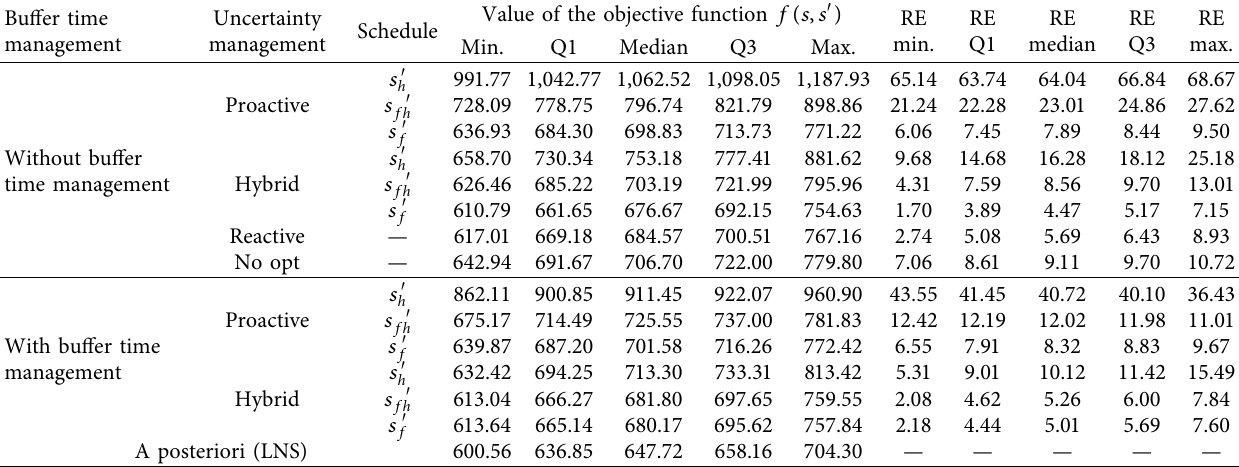
Table 4: Performance comparison between a posteriori uncertainty management and proactive, reactive, and hybrid solution approaches. Buffer